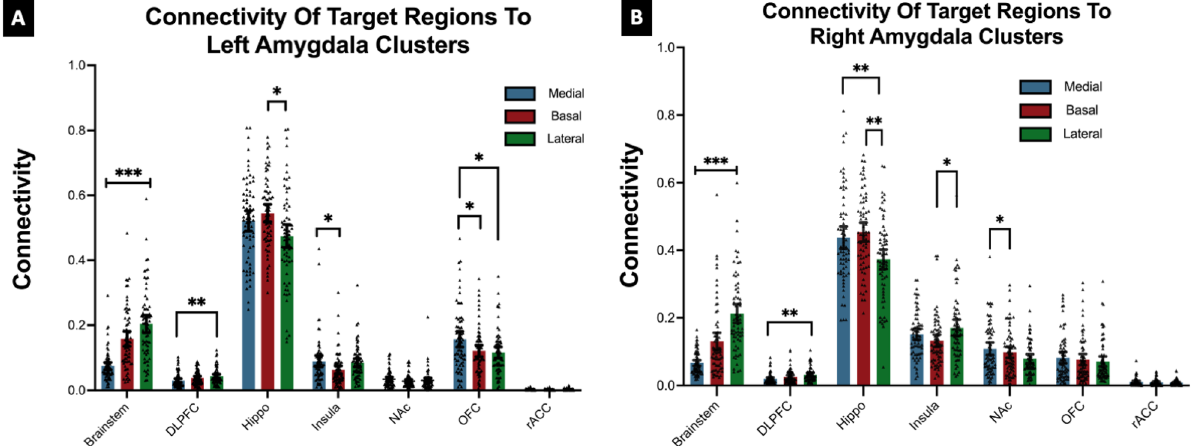
Figure 4. Connectivity (measured by probability of connectivity 0–1, y axis) of the seven target regions to each amygdala cluster. DLPFC (dorsolateral prefrontal cortex), Hippo (hippocampus), NAc (nucleus accumbens), OFC (orbitofrontal cortex), rACC (rostral anterior cingulate cortex). *= p ≤ 0.05, **= p ≤ 0.01, ***= p ≤